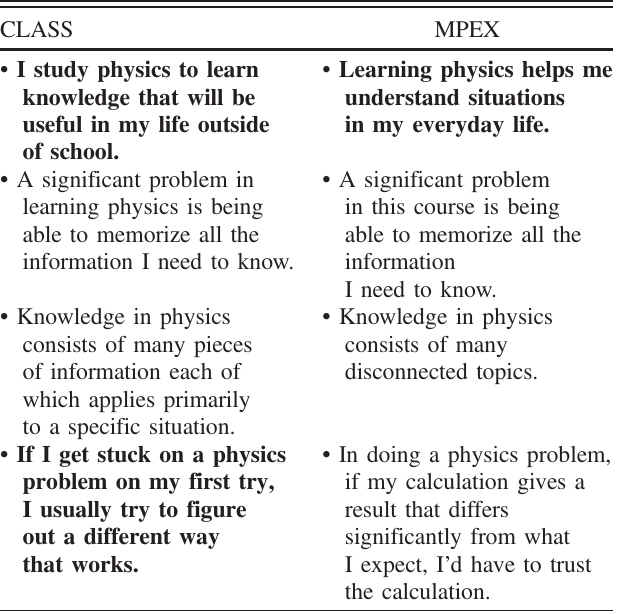
TABLE I. Example items from the CLASS and MPEX. State- ments that experts agree with are indicated in